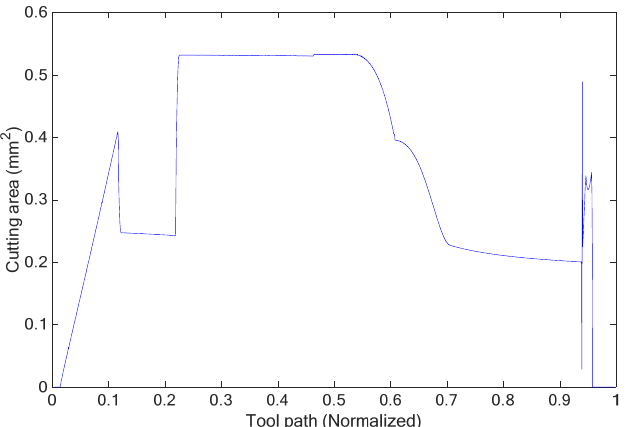
Figure 8. Cutting area per cutter tooth in the rough machining process.